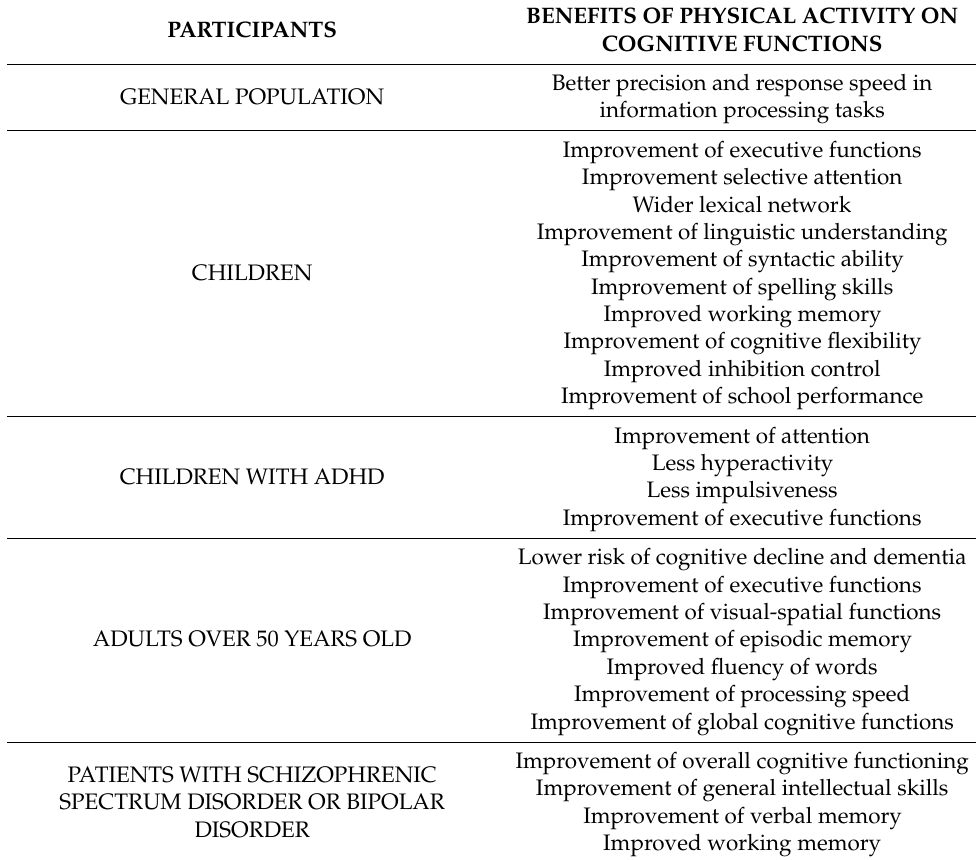
Table 1. Positive effects of physical activity on cognitive